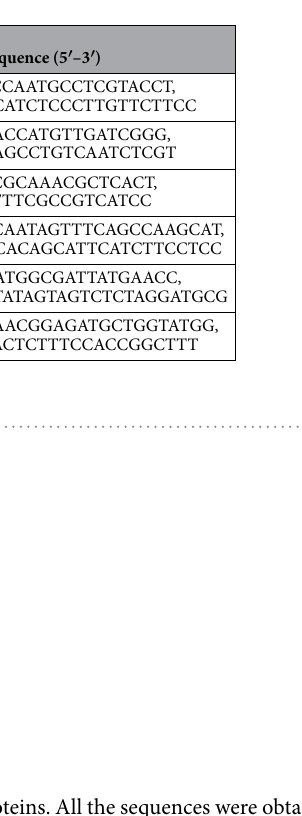
Figure 1. Neighbour-joining tree of full-length CSAD proteins. All the sequences were obtained through the GenBank